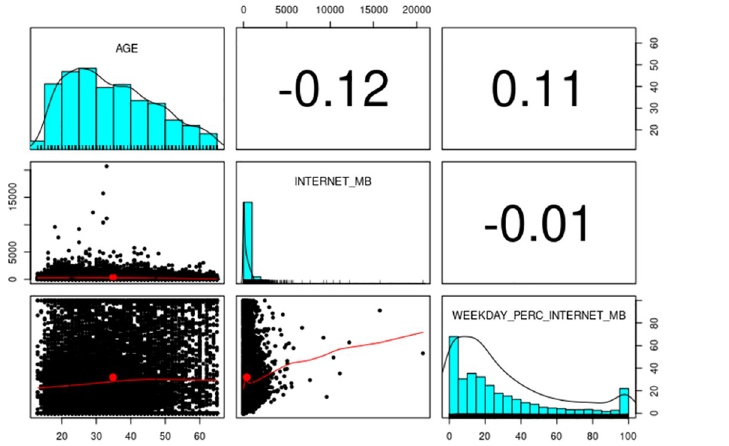
Fig 2. Correlation between response variable and atomic/derived dimensions.